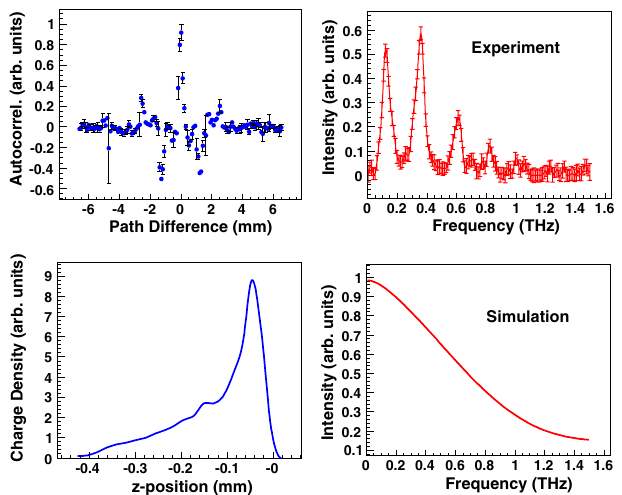
FIG. 3. (Color) Interferometer response functions. Top plot: response function of the interferometer with pyroelectric detec- tors from simulation (red bullets) and direct measurements (open circles). Bottom plot: response function of the interferometer equipped with a Golay detector from simulation. In both cases the simulation results were obtained from the division of the measured intensity spectrum and the simulated one when 0.5 nC electron bunches are at maximum